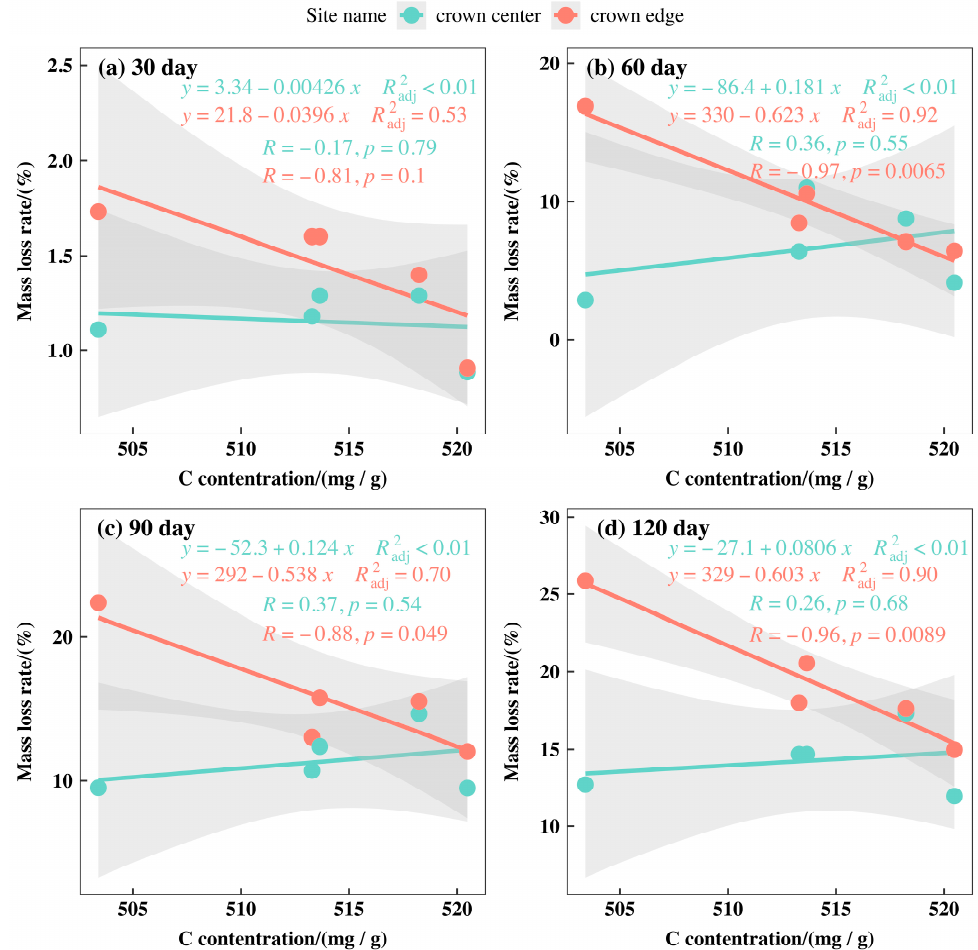
Figure 13. Linear relationships between initial litter C concentration and accumulated mass loss for each sampling day of CC and CE. ( a ) The linear relationship between initial litter C concentration and accumulated mass loss in 30 days. ( b ) The linear relationship between initial litter C concentration and accumulated mass loss in 60 days. ( c ) The linear relationship between initial litter C concentration and accumulated mass loss in 90 days. ( d ) The linear relationship between initial litter C concentration and accumulated mass loss in 120